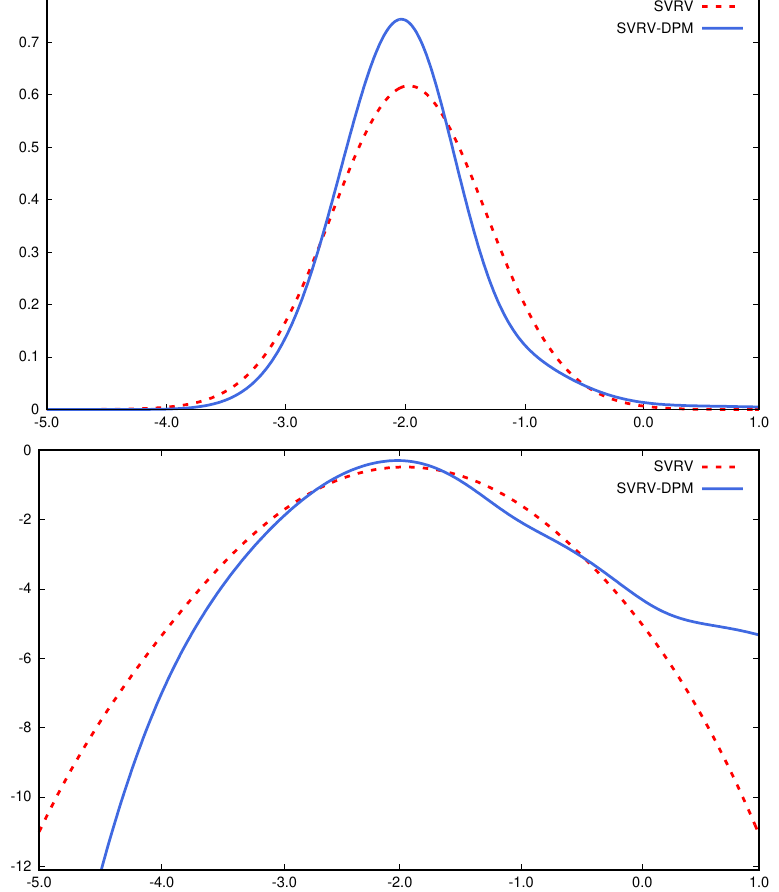
Figure 6. ( Top ): Predictive logRV density p ( log ( RV t + 1 ) | y 1: t ) ; ( Bottom ): Log predictive logRV density log p ( log ( RV t + 1 ) | y 1: t ) of the RSV-DPM and RSV